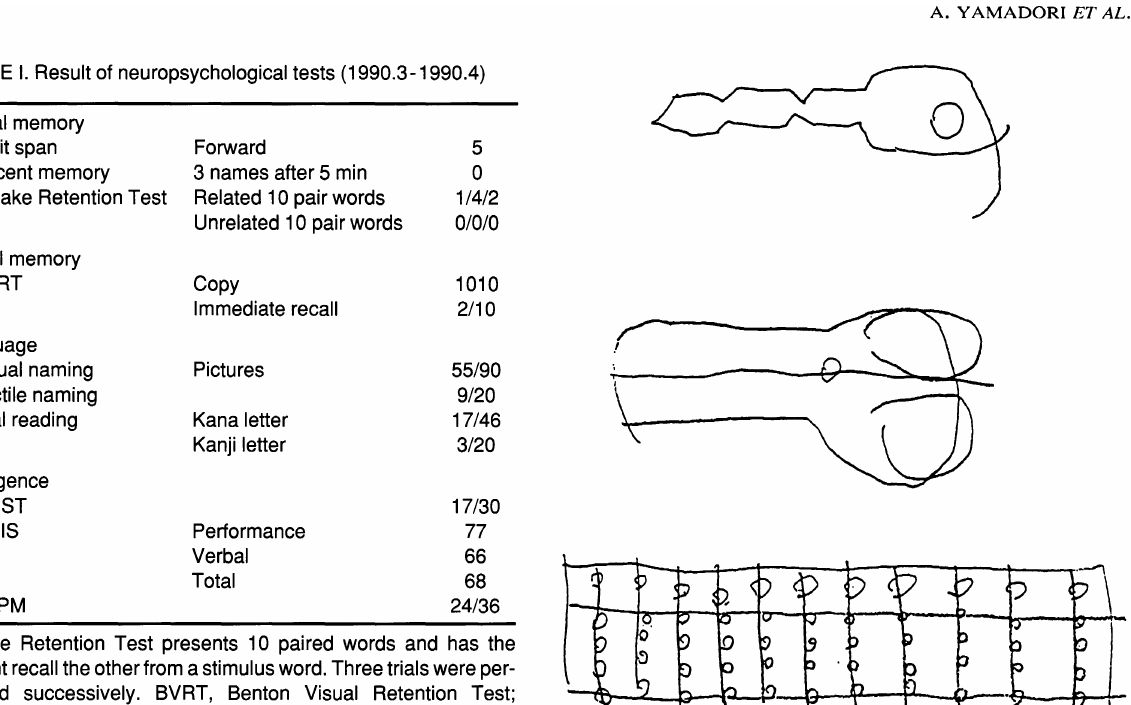
FIG. 1. Examples of his drawings of unidentifiable objects. From top to bottom: key, SCissors, and Japanese style